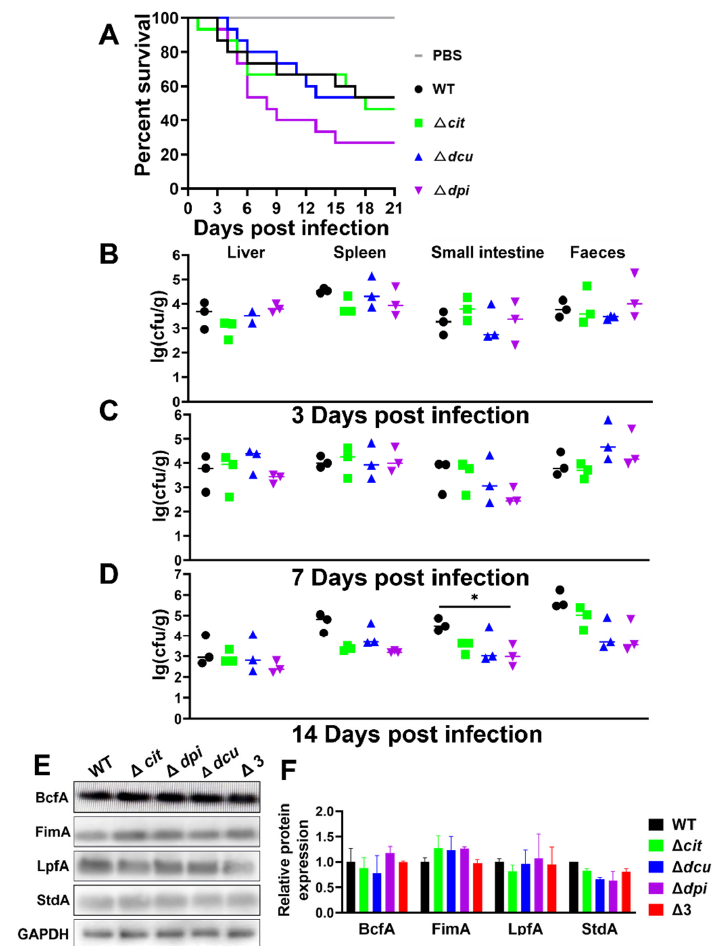
Figure 5. Deletion of Dpi TCS was detrimental to long-term colonization of the small intestine but did not affect the expression of the fimbrial protein. ( A ) Survival curves for chickens infected with WT and mutants. One-day-old chickens were inoculated, each strain with 10 6 CFU, by oral injection and monitored for 21 days. ( B – D ) Bacterial loads in the liver, spleen, small intestine tissues and faecal samples 3 ( B ), 7 ( C ) and 14 ( D ) days post-infection. ( E ) Western blotting analysis detected fimbrial protein expression of WT and mutants. The GAPDH was used as a reference. ( F ) The relative expression level of four fimbrial proteins in WT and mutants. The statistical significance of differences was evaluated by one-way ANOVA test (* p < 0.05).